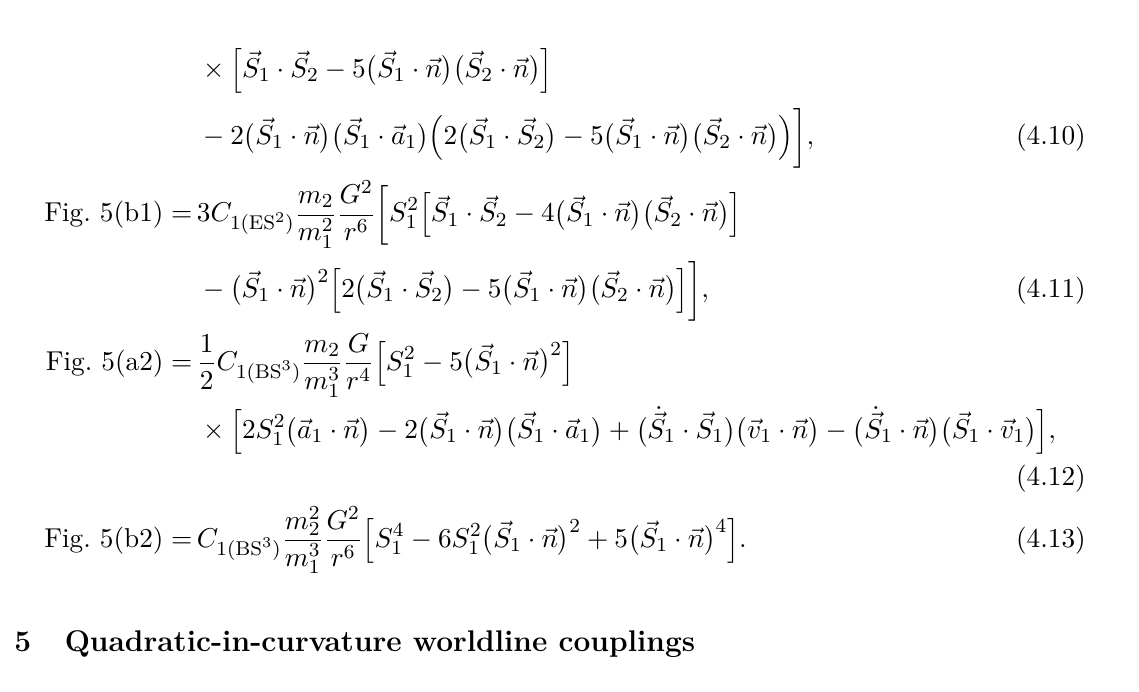
Figure 6 . The Feynman graph of two-graviton exchange at the NLO quartic-in-spin interaction, which originates from the new quadratic-in-curvature operator with the hexadecapole and with a new Wilson